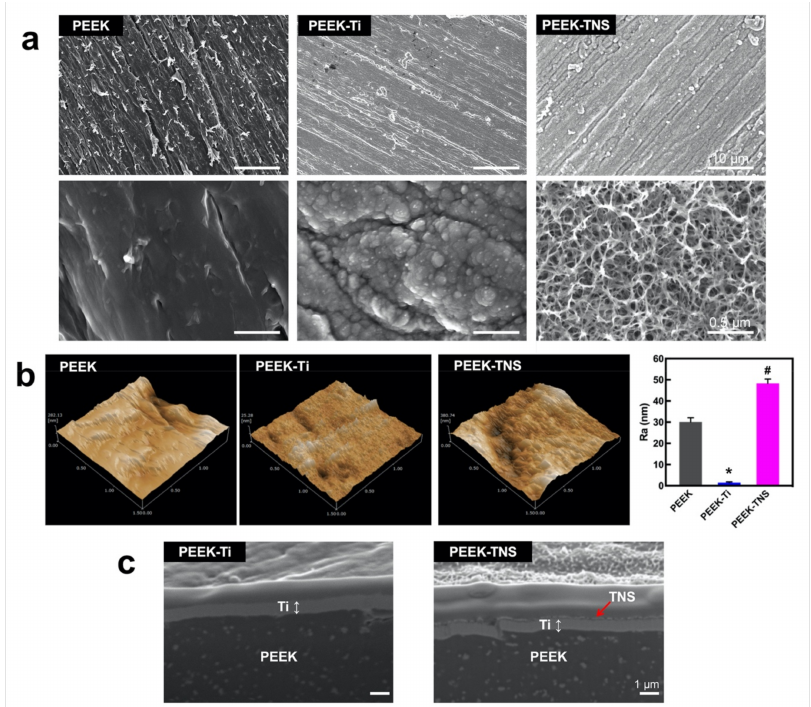
Figure 1. The surface morphology of PEEK, PEEK-Ti, and PEEK-TNS. ( a ) SEM images, scale bar = 10, 0.5 µ m. ( b ) Three-dimensional surface topography detected by SPM and the mean average surface roughness (Ra). ( c ) Cross-sectional morphology of PEEK-Ti and PEEK-TNS, scale bar = 1 µ m. (* represents p < 0.05 when PEEK-Ti is compared with PEEK; # represents p < 0.05 when PEEK-TNS is compared with PEEK-Ti).